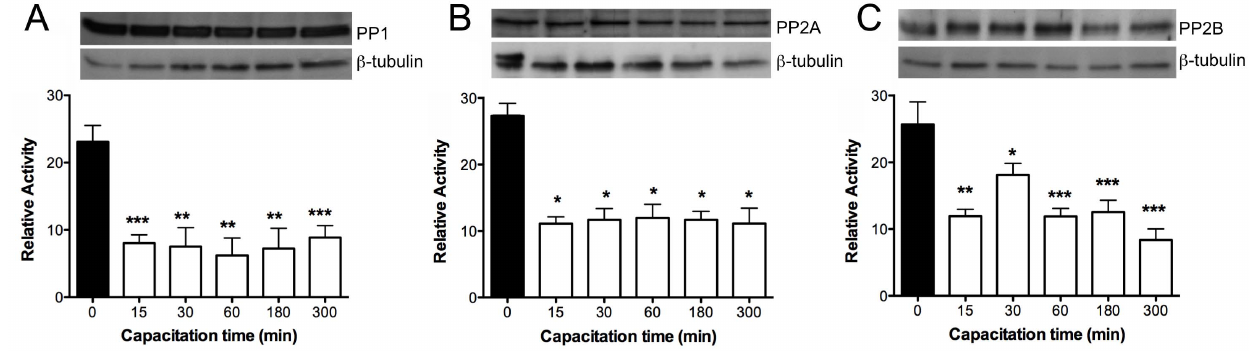
Figure 5. Specific enzymatic activity of PP1 (A), PP2A (B), and PP2B (C) during human sperm capacitation. Sperm were selected and re- suspended in NCM and the PPs activity was measured immediately (black bar, T0). Then, sperm aliquots were resuspended in RCM and incubated at 37 u C and 5% CO2 for up to 300 min. Different aliquots were taken at the indicated times and the PPs activity measured as indicated in Materials and Methods (white bars). Results were obtained from four different donors and are expressed as the mean 6 SEM of forty measurements every 2 min. * p , 0.05; ** p , 0.005; *** p , 0.001. The enzymatic activity is expressed as relative activity. In the insert, the upper panel represents the expression of PP1 (A), PP2Ac (B), and PP2B (C) during the corresponding capacitation times; the lower panel corresponds to the load control with anti b -tubulin antibody. doi:10.1371/journal.pone.0081286.g005 PPs. We first confirmed the presence of PP1 and PP2B in human and PP1 c 2. Previous studies have described the presence of PP1 c 1 and PP1 c 2 isoforms in human and monkey sperm extracts [12]. sperm via western blot. PP1 and PP2B have been described in bovine [46], goat [47], canine [20], sea urchin [48], and human sperm [19,23]. In mammals, the catalytic subunit of PP1 has four isoforms that are encoded by three different genes: PP1 a , PP1 b , and PP1 c . PP1 c presents two splicing alternative isoforms: PP1 c 1